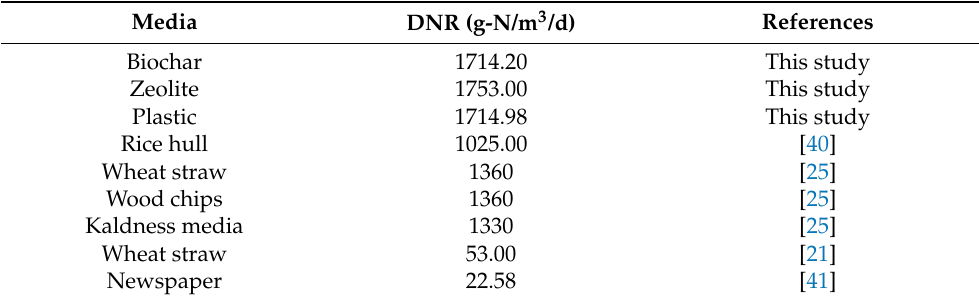
Table 2. The DNR of different media used in the treatment of aquaculture